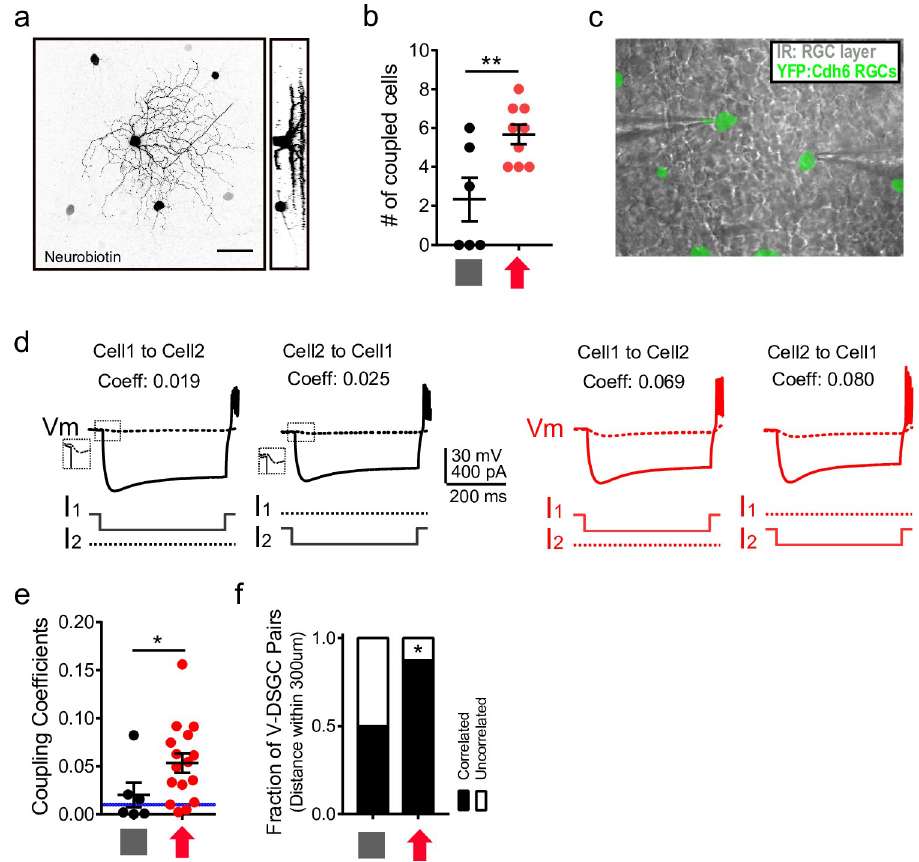
Fig 6. Stronger gap junction connections in V-DSGCs after upward VME. (a) Neurobiotin labeling showing dendritic arborization of a V-DSGC and the somata of neighboring RGCs that are coupled to it. Scale bar, 50 μ m. (b) Number of cells coupled to V-DSGCs revealed by neurobiotin labeling of V-DSGCs. Control, 6 V-DSGCs, 2.3 ± 1.1 coupled somata; VME, 9 V-DSGCs, 5.7 ± 0.5 coupled somata. Unpaired t test, p < 0.01. (c) Face-on view of a Cdh6-CreER × Thy1-stop-YFP mouse retina captured during a paired intracellular recording session. Gray, infrared illuminated RGC layer; green, fluorescence of YFP. (d) Electrical coupling between a pair of V-DSGCs each in the control (black) and upward gratings VME (red) groups, as revealed by targeted paired intracellular recording in the Cdh6-CreER × Thy1-stop-YFP retina. In both cases, − 200 pA current injection in cell 1 caused hyperpolarization in cell 2 and vice versa. Coupling coefficients are indicated on top. (e) Coupling coefficients for V-DSGC pairs. Control, 6 pairs, mean coupling coefficients 0.02 ± 0.01; VME, 16 pairs, mean coupling coefficients 0.05 ± 0.01. Dashed line shows the threshold for significant coupling. Unpaired t test, p < 0.05. (f) Fraction of electrically coupled V-DSGCs. Control, 50%, 6 pairs; VME, 87.5%, 16 pairs. Chi-squared test, p < 0.05. Data for this figure are in S6 Data. IR, infrared; RGC, retinal ganglion cell; V-DSGC, ventral-preferring direction selective ganglion cell; Vm, membrane potential; VME, visual motion experience; YFP, yellow fluorescent protein.